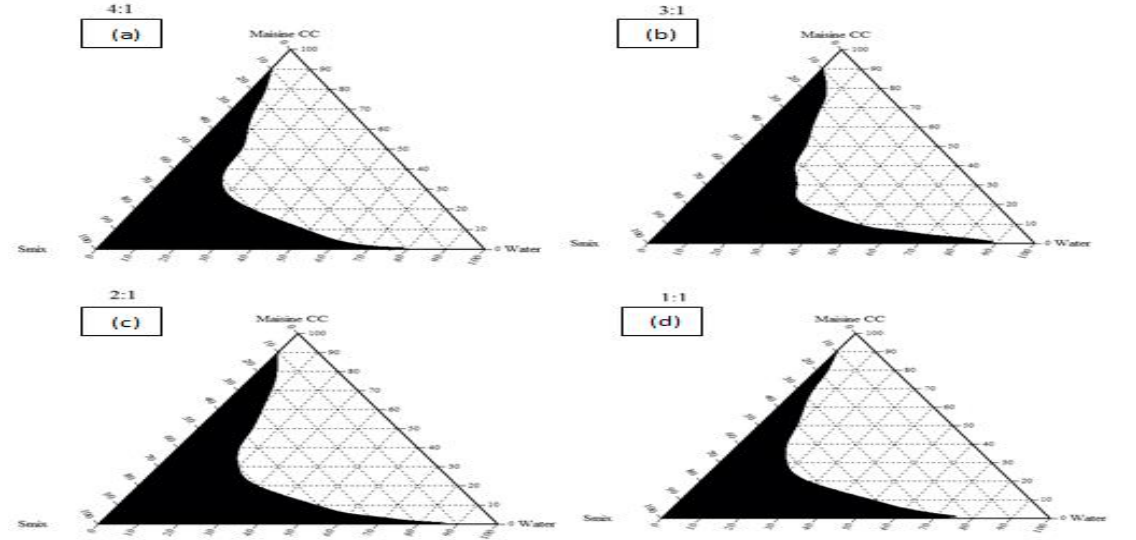
Figure 5. Pseudoternary phase diagram of Smix (a) (4:1); (b) (3:1); (c) (2:1); (d)